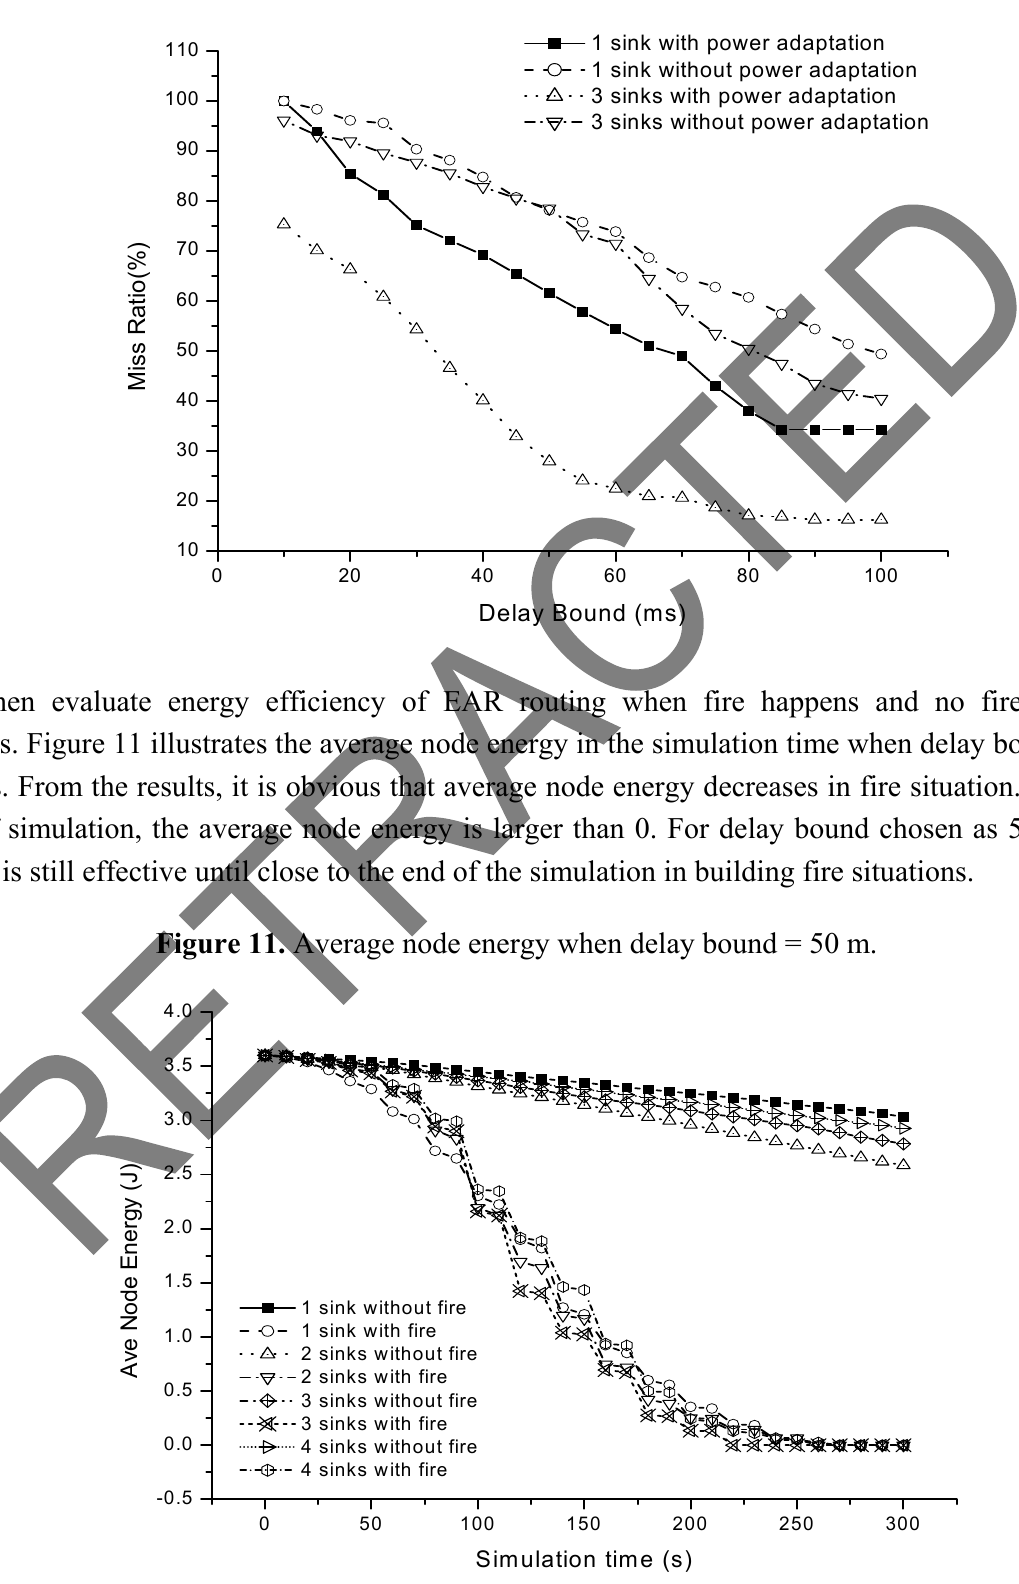
Figure 10. Miss ratio with/without power adaptation.